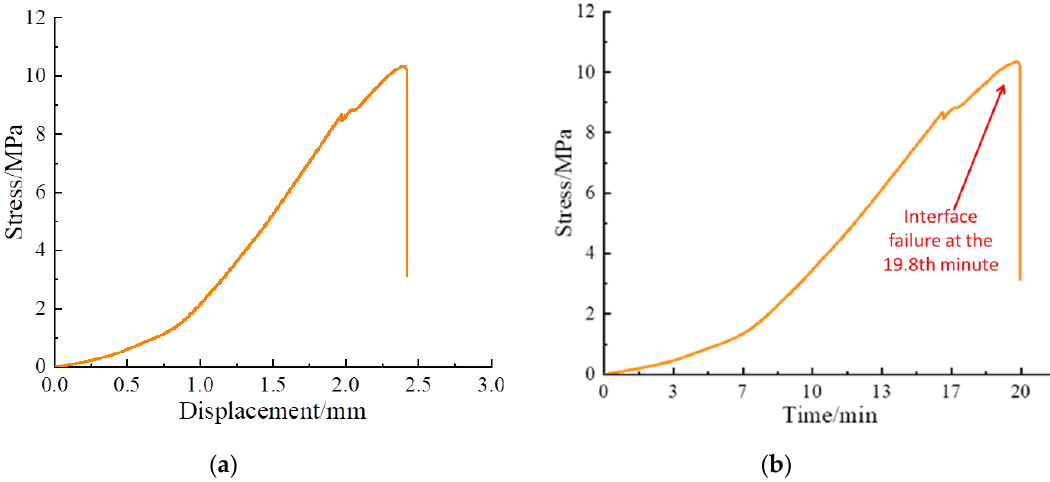
Figure 10. Shear test curve of Composite specimen Ⅱ : ( a ) Shear stress-displacement curve; ( b ) Shear stress-time curve .